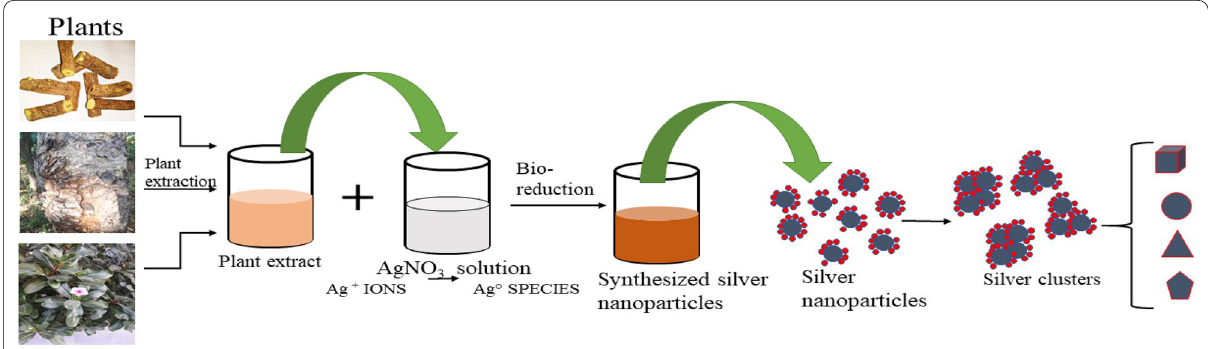
Fig.1 Synthesis of AgNPs through Green synthesis method